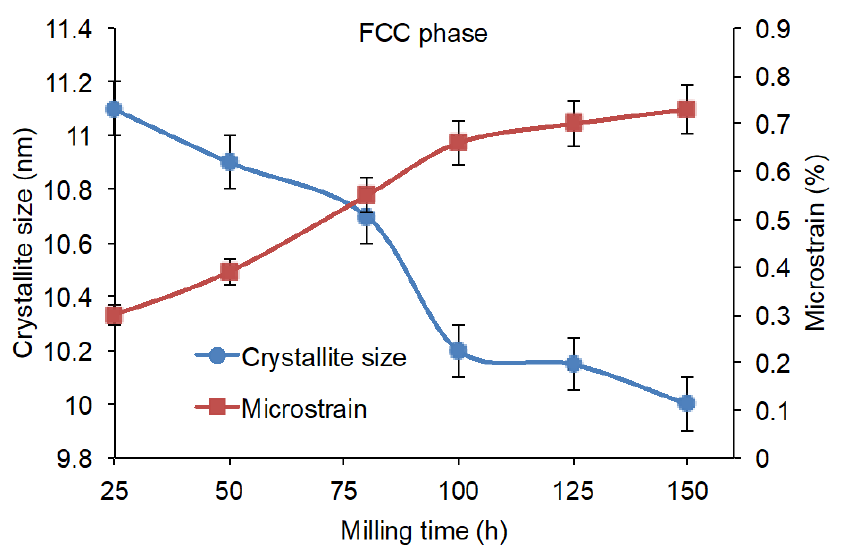
Figure 5. Dependence of the microstructure parameters of the FCC Fe–Co–Ni–(B,Si) as a function of the milling time.